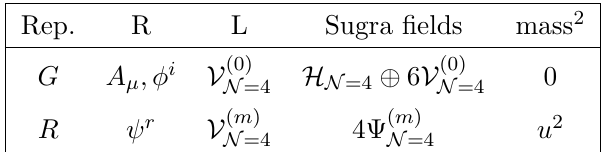
Table 3 . Fields and mass spectra for the CSS gauging of N = 8 supergravity with N = 4 residual